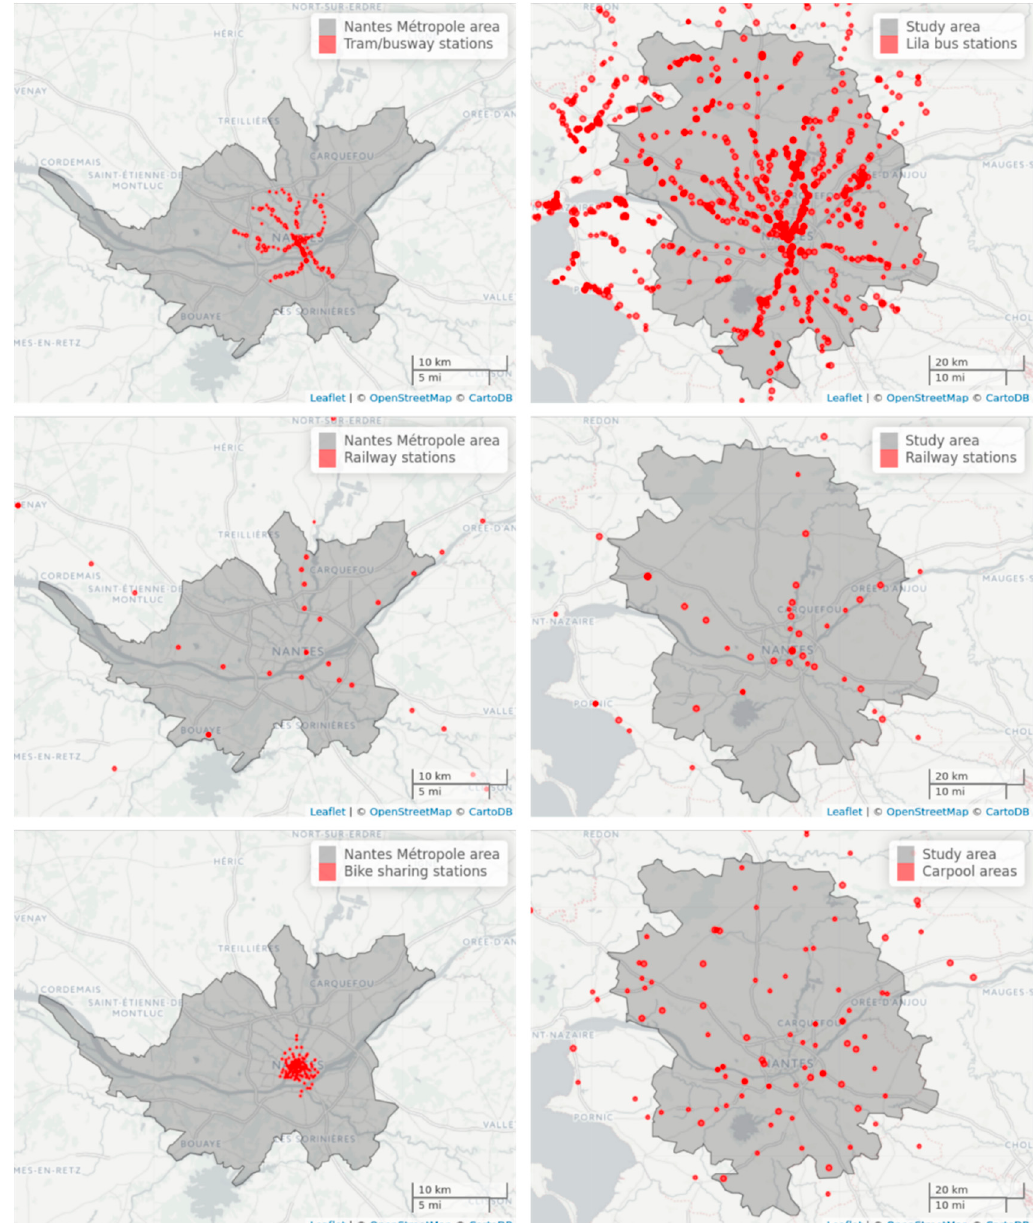
Figure 2. Sustainable transport infrastructure and study areas.